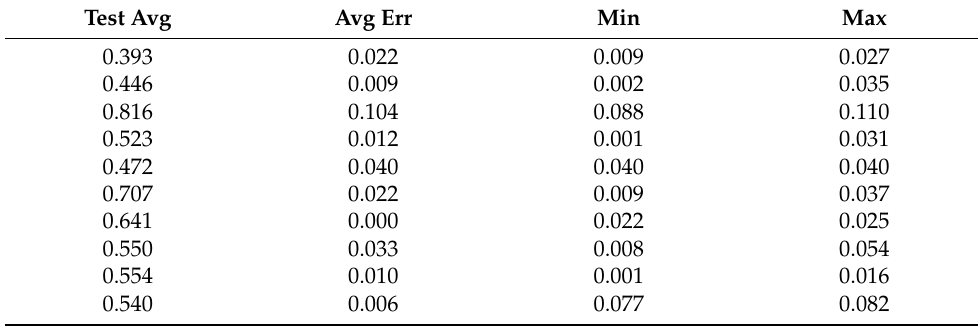
Table A164. Set 3, trials 1–10 data (average actual PR values).